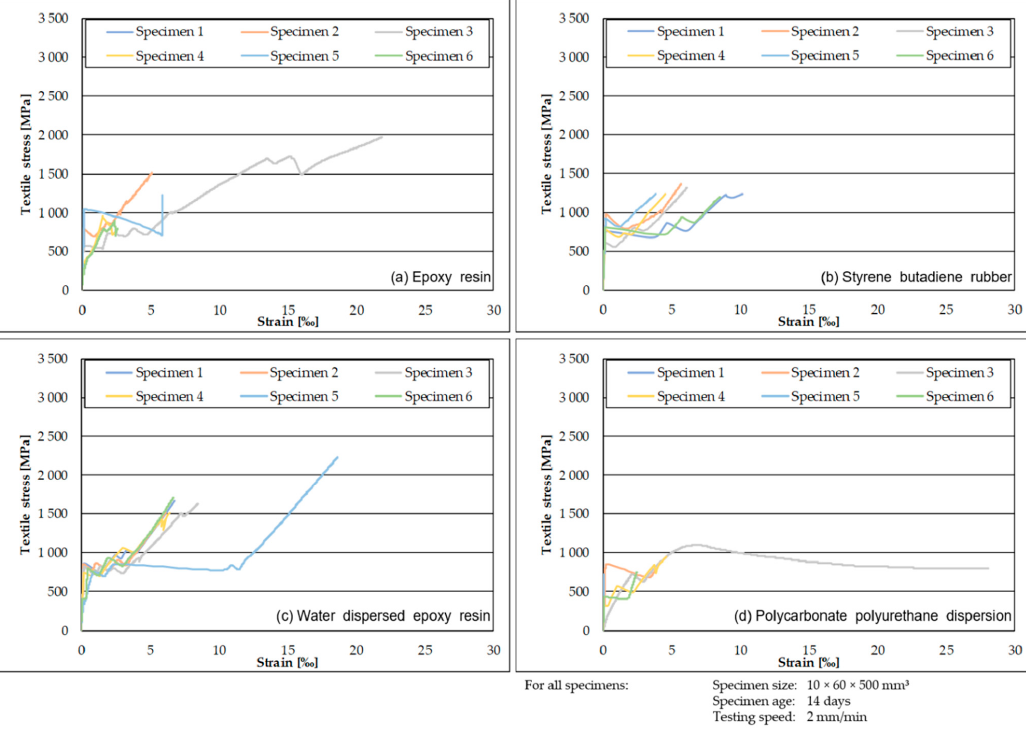
Figure 9. Resulting stress–strain curves of all FoF tensile tests: ( a ) epoxy resin; ( b ) styrene butadiene rubber; ( c ) water ‐ dispersed epoxy resin; ( d ) polycarbonate polyurethane dispersion.